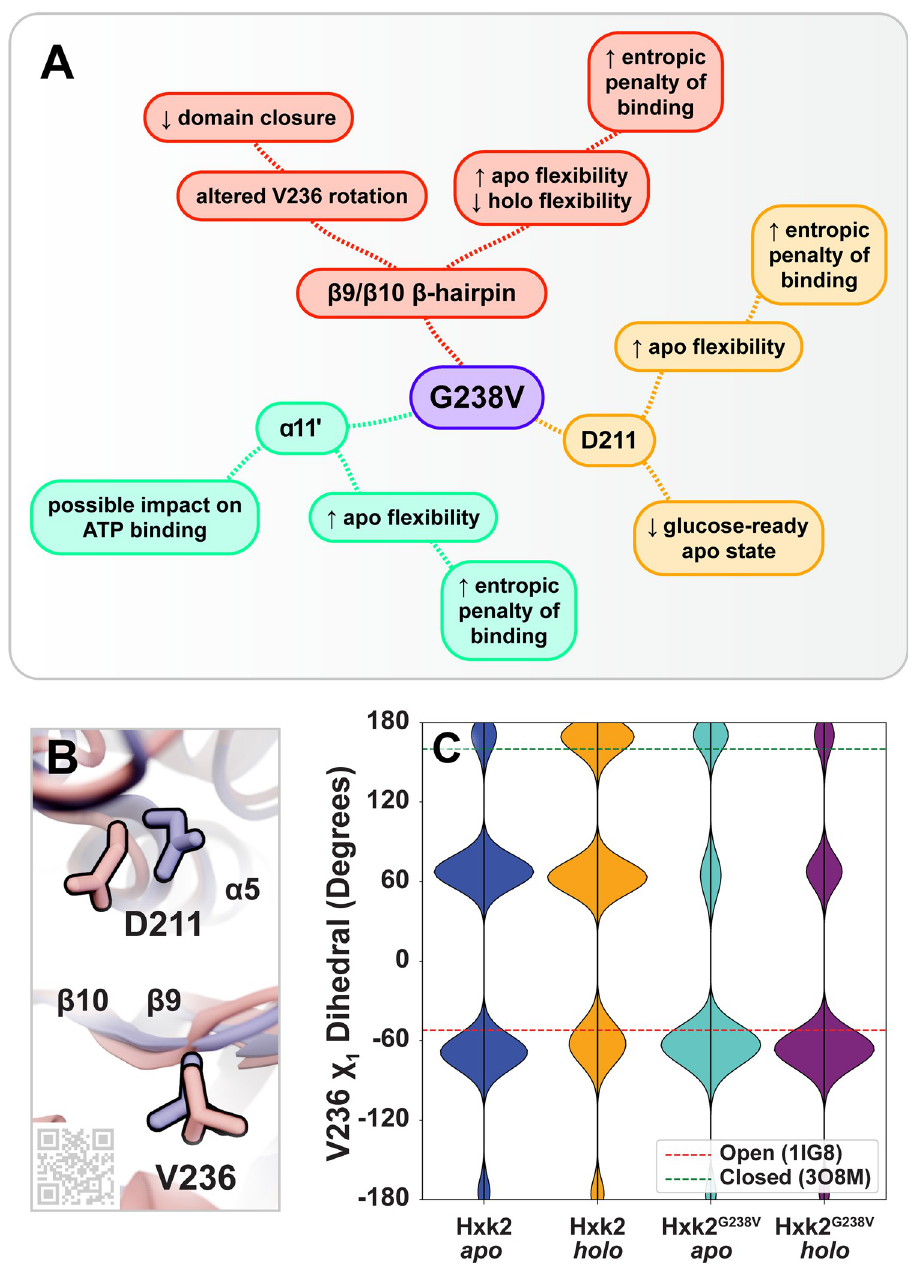
Fig 7. Hypothesized impacts of Sc Hxk2 G238V on the catalytic mechanism. (A) The G238V mutation alters the dynamics of the β 9/ β 10 β -hairpin, the catalytic D211 residue, and the α 11’ helix. The implications of these changes on enzyme function are summarized. (B) Two conformations taken from the Sc Hxk2 G238V apo simulations highlight the movements of V236 (loop residue) and D211 (catalytic residue). In blue, V236 is shown in an open-like conformation, and D211 is shown in a glucose-ready conformation. In pink, V236 is shown in a closed-like conformation, and D211 is shown in a displaced conformation. Key secondary-structure elements are labeled with text, and the substrate- adjacent loop is labeled by its residues (I231-V236). The QR code provides a link to an online ProteinVR scene for virtual-reality visualization. (C) The distributions of the V236 χ 1 dihedral angle. For reference, the red and green dashed lines show the corresponding values of the 1IG8 ( Sc Hxk2, open) and 3O8M ( Kl Hxk1, closed) crystal structures, respectively.